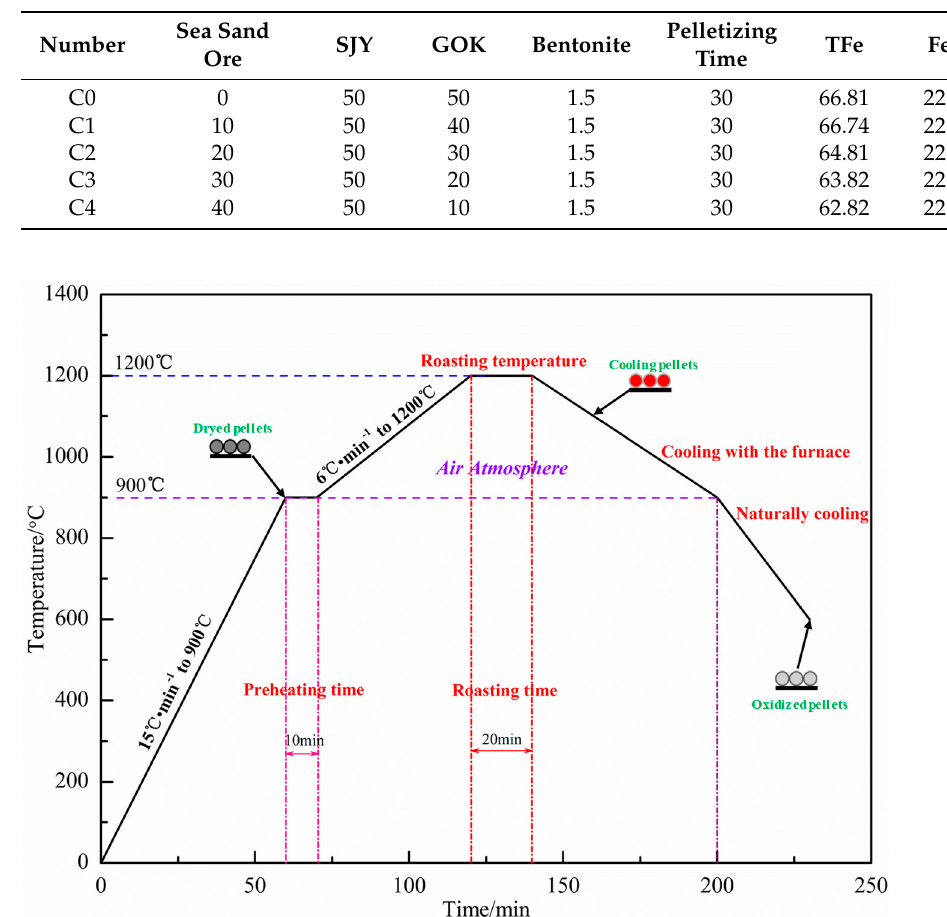
Figure 4. Roasting system of green